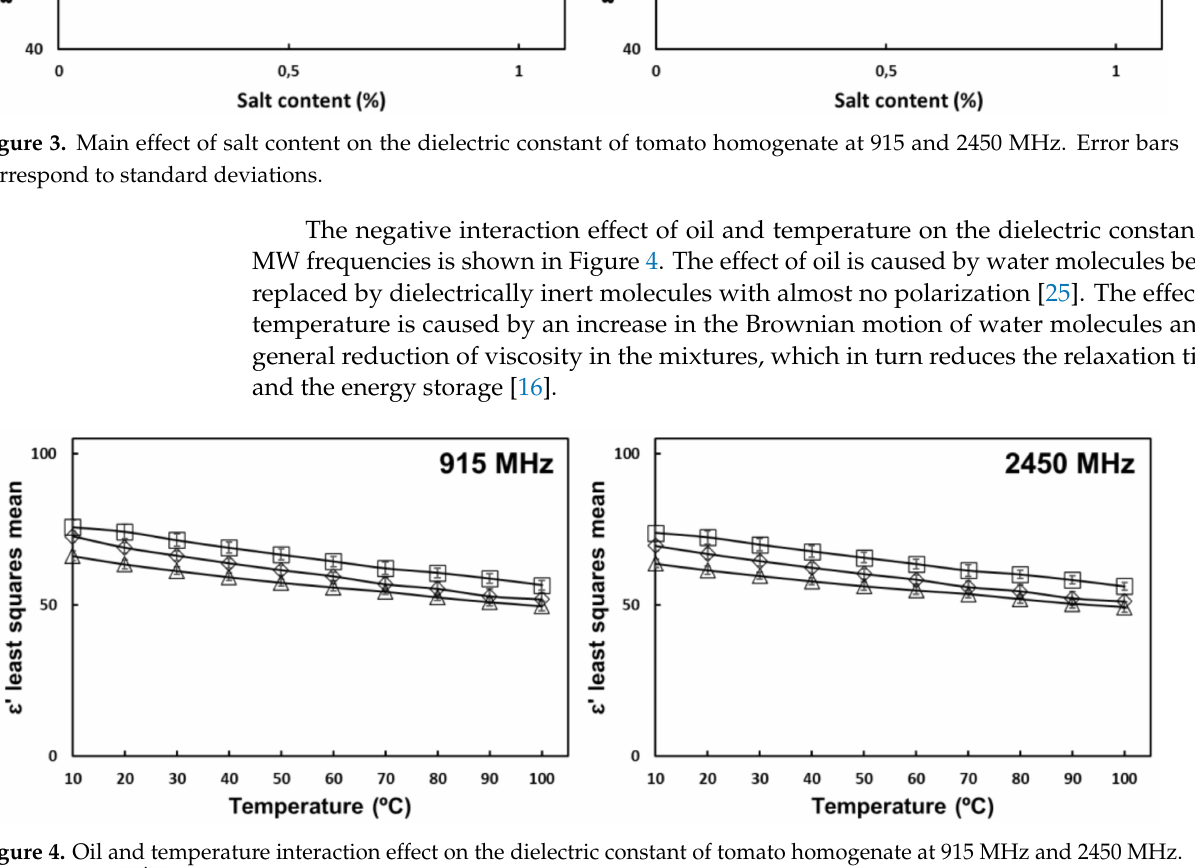
Figure 4. Oil and temperature interaction effect on the dielectric constant of tomato homogenate at 915 MHz and 2450 MHz. ( ) 0% oil ( ) 5% oil ( ) 10% oil. Error bars correspond to standard